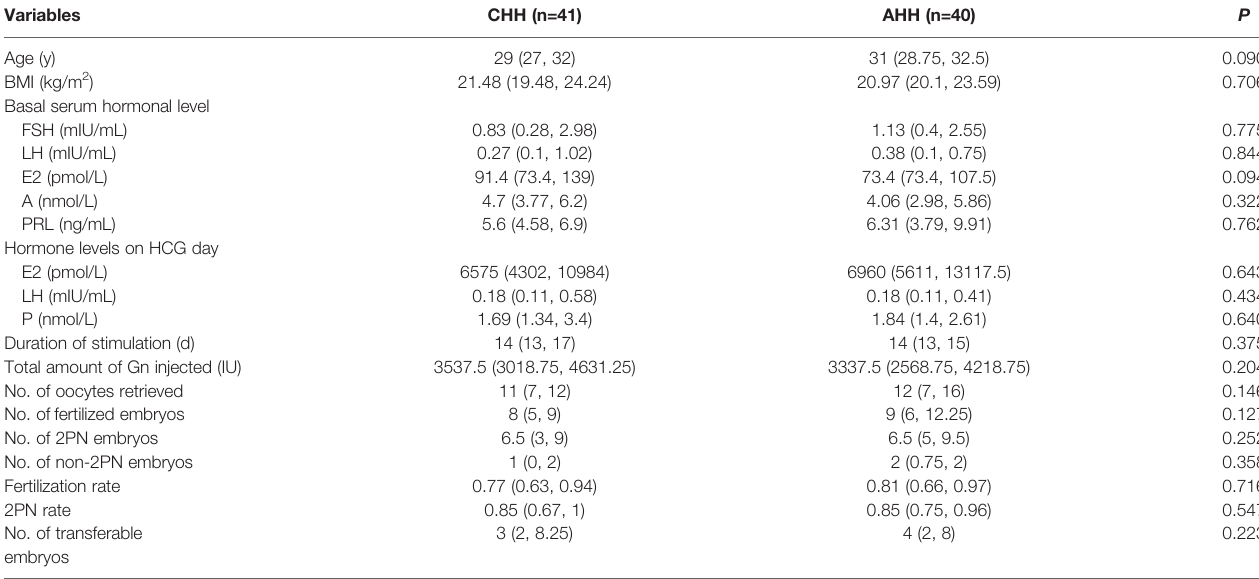
TABLE 5 | Comparison of clinical and cycle characteristics between congenital hypogonadotropic hypogonadism (CHH) and acquired hypogonadotropic hypogonadism (AHH) groups. Variables